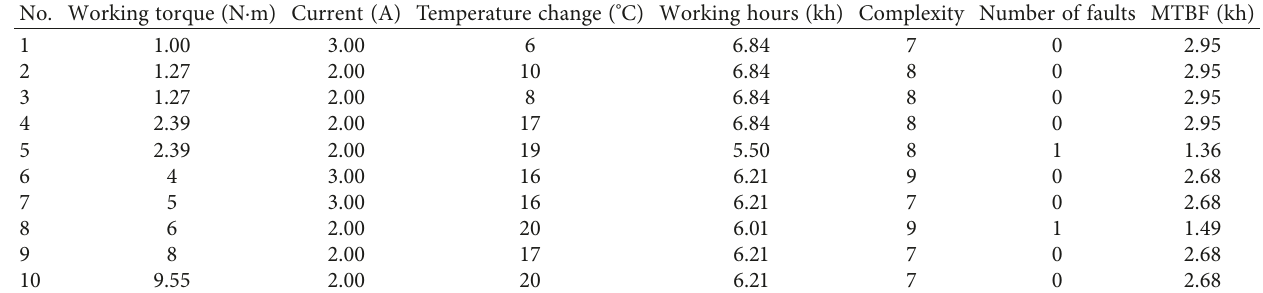
Figure 3: Test procedure. Table 2: Original sample data.